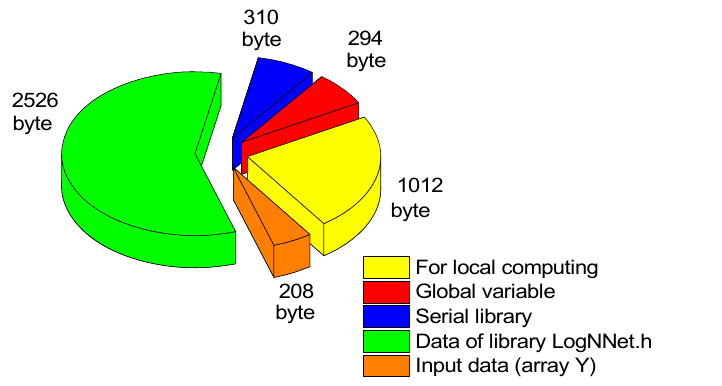
Figure 8. Estimation of the RAM used by the Arduino controller when working with the neural network LogNNet 51:50:20:2.